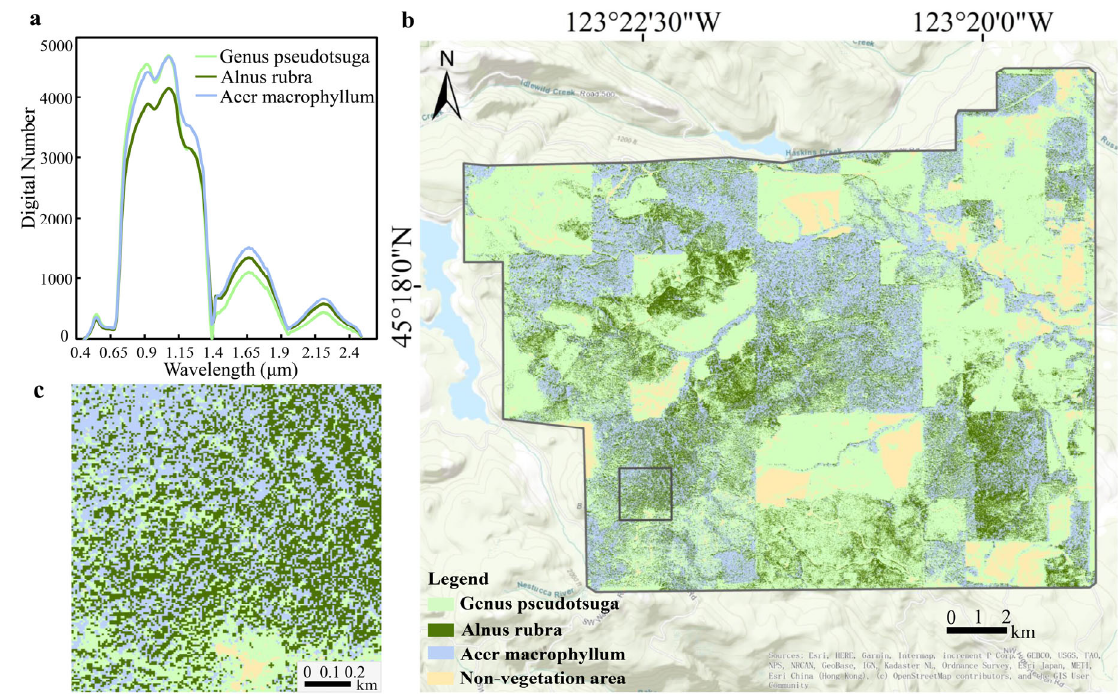
Figure 5. ( a ) The spectral reflectance of three tree species in PC. ( b ) The tree ‐ species distribution map was derived from the optimal variable combination. ( c ) The classification result of tree species in sample plot.